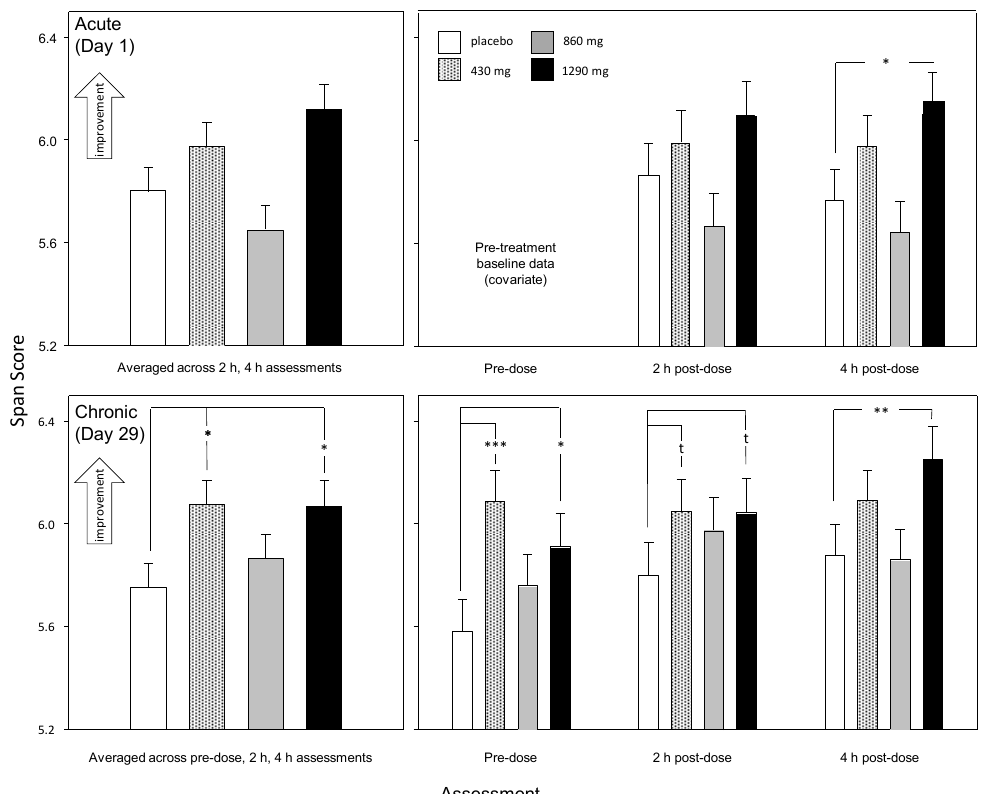
Figure 4. Corsi Blocks working memory task. The effects of treatment from the acute (Day 1) analysis (top panels) and the chronic (Day 29) analysis. Data are estimated means (plus SE) derived from the ANCOVA / LMM analysis, using pretreatment (Day 1 pre-dose assessment) data and participant’s age as covariates. The left-hand panels show the results of planned comparisons between placebo and each dose of green oat extract using data averaged across the day, and the right-hand panels shows